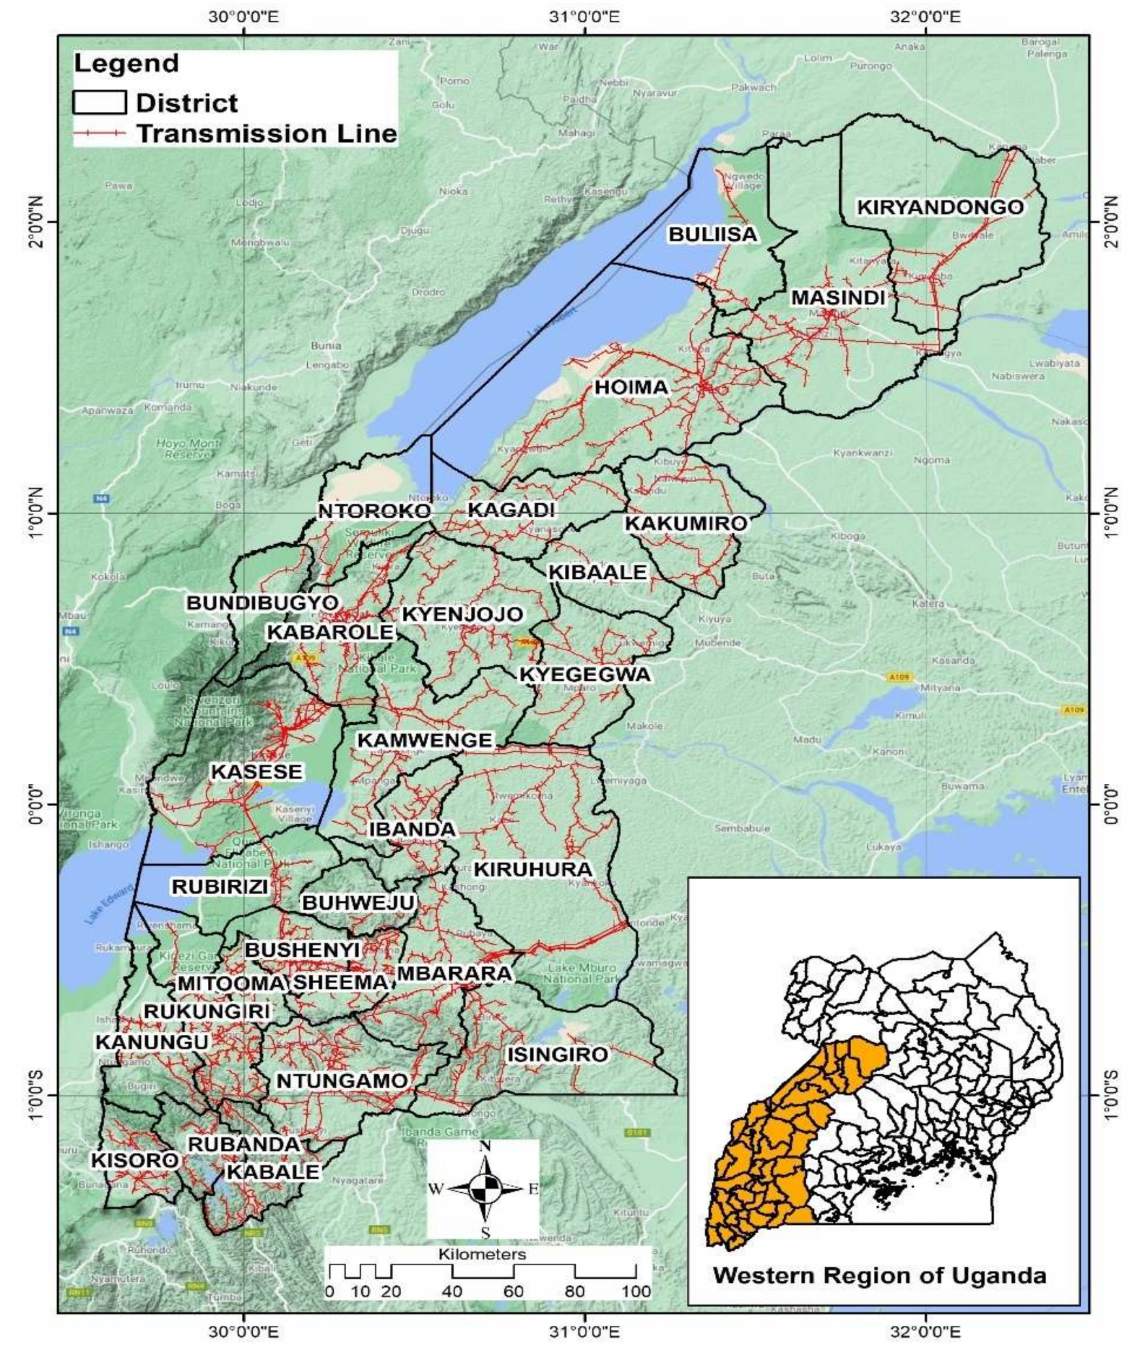
Figure 2. Distribution map of transmission lines in the study